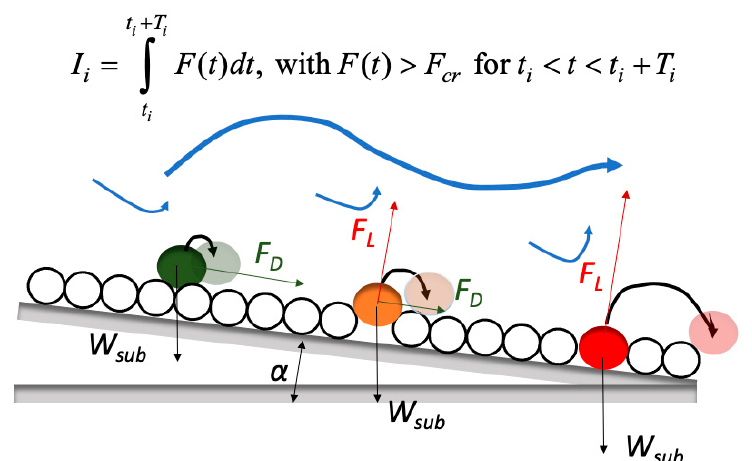
Figure 2. Demonstration of the dominant above-threshold hydrodynamic forcing modes for a particle hopping out of its pocket, leading to transport by saltation. Hydrodynamic impulse is defined as the temporal integral of the total force acting on the particle. This can primarily be the hydrodynamic drag (F D ), lift (F L ), or a combination of both forces, for the cases of a particle fully exposed, partially hidden, and buried in the bed surface (shown in green, orange, and red, respectively).